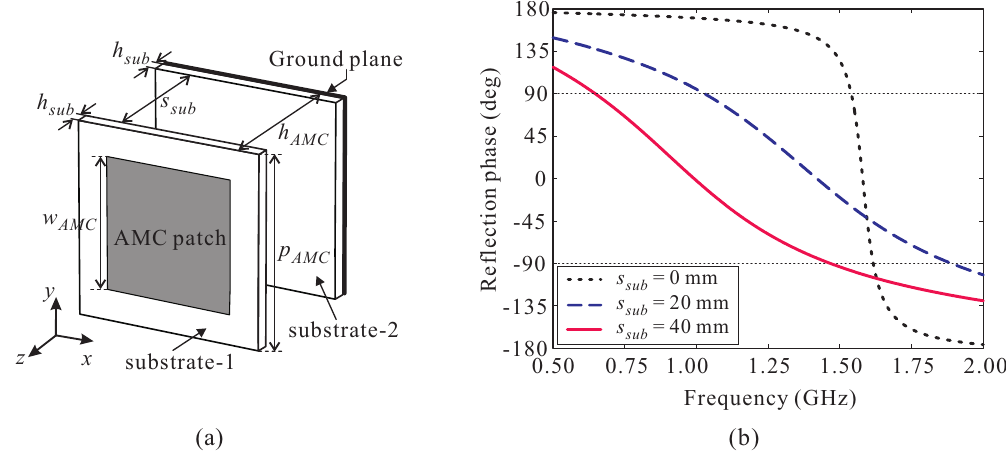
Figure 4. ( a ) Geometry of the artificial magnetic conductor (AMC) unit cell; ( b ) Simulated reflection phase versus the spacing between two substrates.